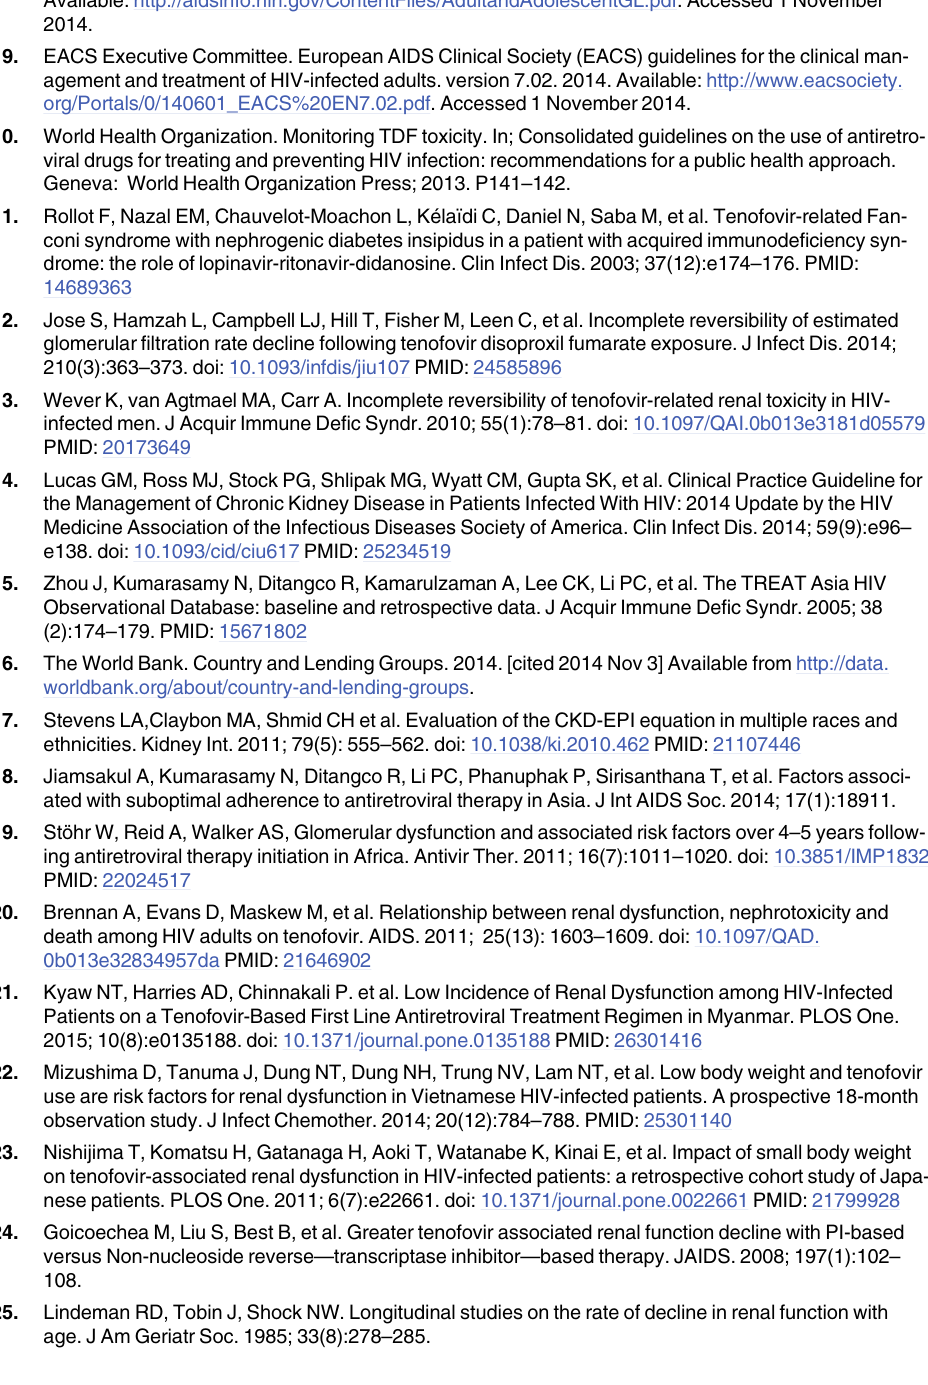
PLOS ONE | DOI:10.1371/journal.pone.0161562 August 25,